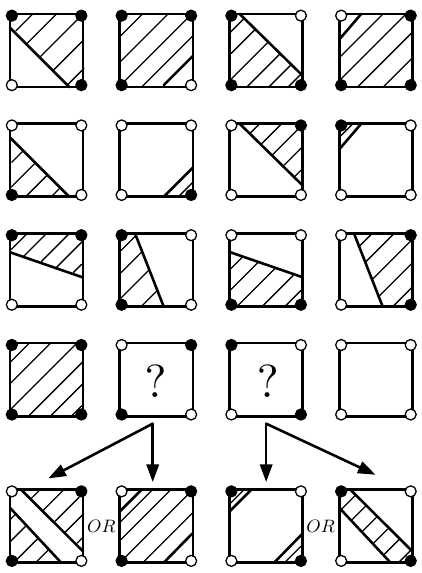
Figure 8. Illustrations of the boundaries and the above-threshold regions with the Marching Square (MS) algorithm.